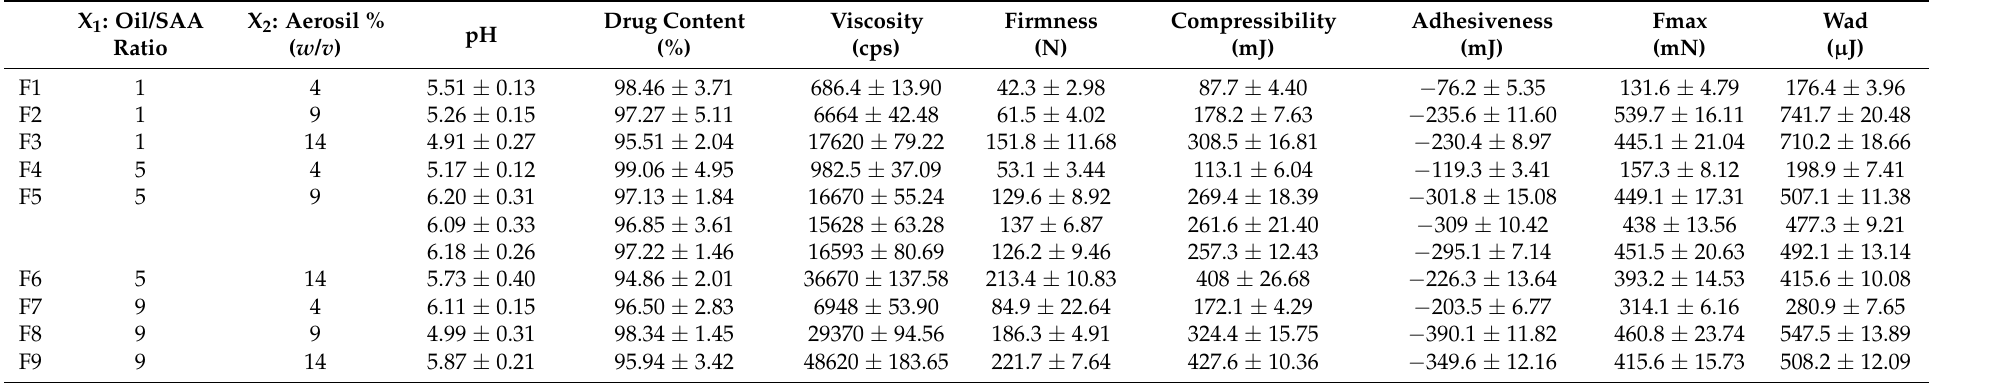
Table 1. Experimental runs, independent variables, pharmaceutical evaluation, and measured responses of the central composite response surface experimental design for OLM prepared oleogel